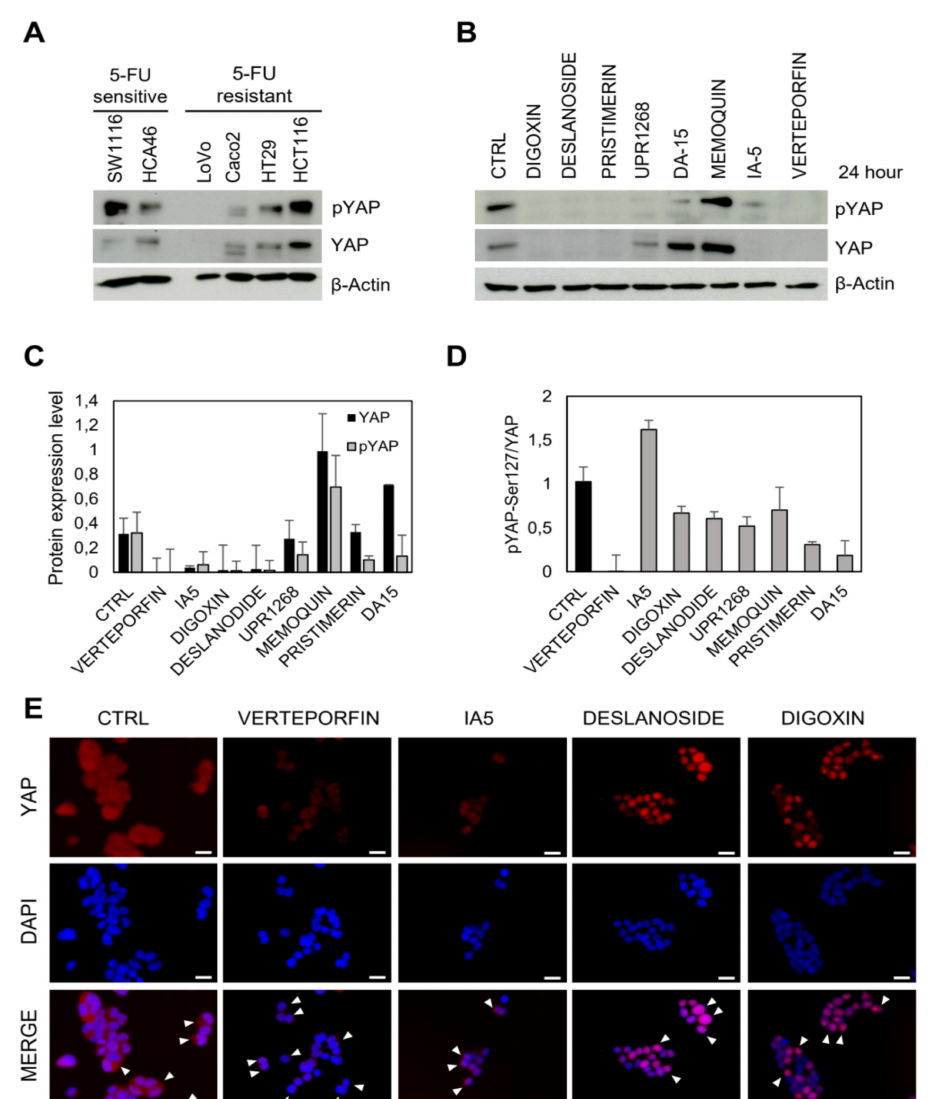
Figure 7. Effects of the compounds on YAP protein levels and phosphorylation status in cancer cell lines. ( A ) Western blotting, showing the basic level of YAP and pYAP-Ser127 levels in a panel of colorectal cancer cell lines; ( B ) protein expression levels of YAP and pYAP-Ser127 after treatment of HT29 cells with the selected compounds (short-exposure blots were used as a representative image); and ( C ) the corresponding densitometric quantification; ( D ) quantification of pYAP-Ser127/YAP ratio; ( E ) immunofluorescent staining of YAP protein after 24 h of treatment with the relative compounds. Verteporfin was used as a reference compound. Error bars represent s.d. (n = 3). Scale bars 25 µ